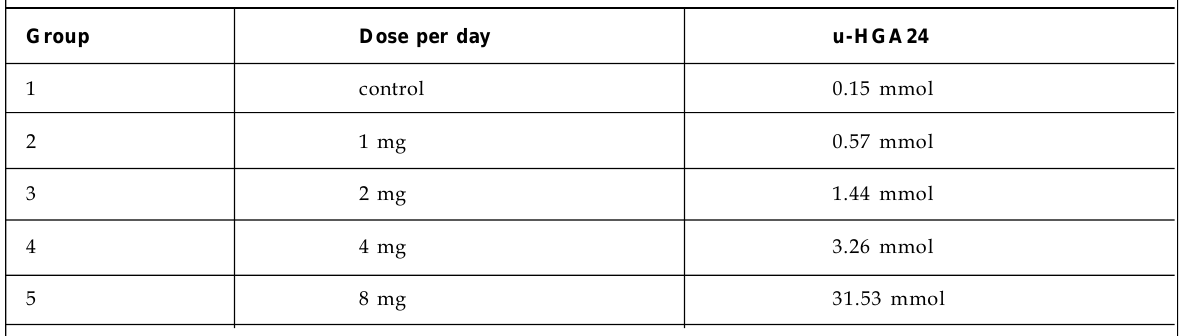
Table 4: Use of nitisinone in AKU patients Group Dose per day